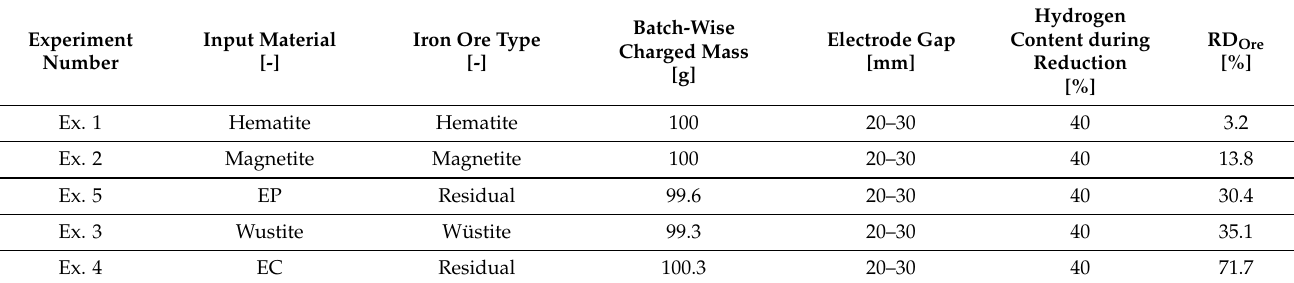
Table 3. Experimental plan (sorted by RD Ore